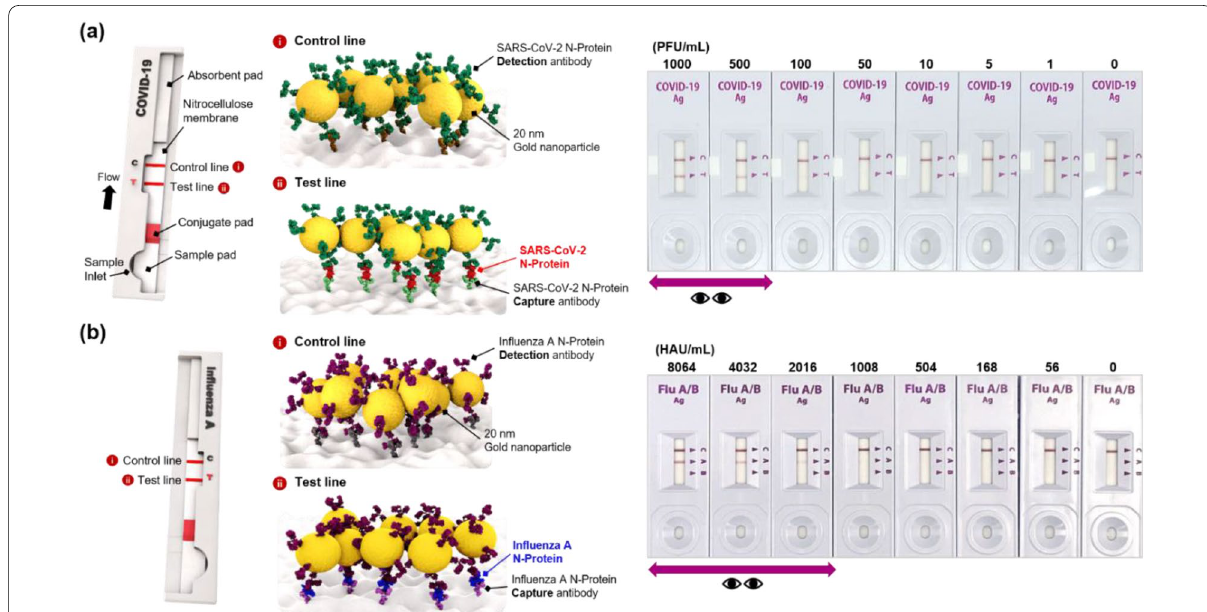
Fig. 1 Detection results of SARS-CoV-2 and influenza A virus lysates using commercially available colorimetric LFA strips. a Assay results of SARS-CoV-2 lysates along with the increase of SARS-CoV-2 concentration in the 0–1000 PFU/mL range. N-protein in SARS-CoV-2 was used as a target antigen. b Assay results of influenza A virus lysates along with the increase of influenza A virus concentration in the 0–8064 HAU/mL range. N-protein in influenza A virus was used as a target